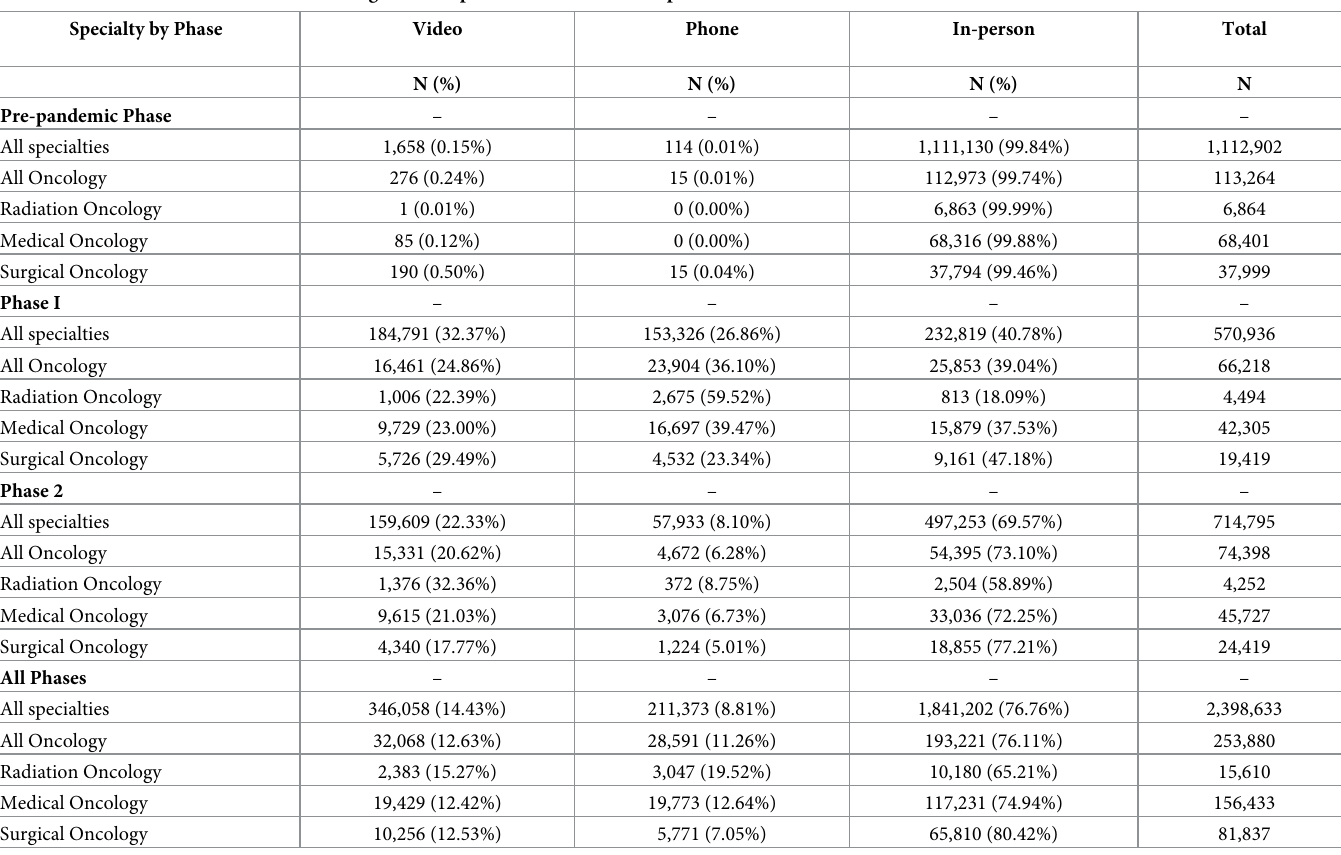
Table 1. Details of visit characteristics during different phases of the COVID-19